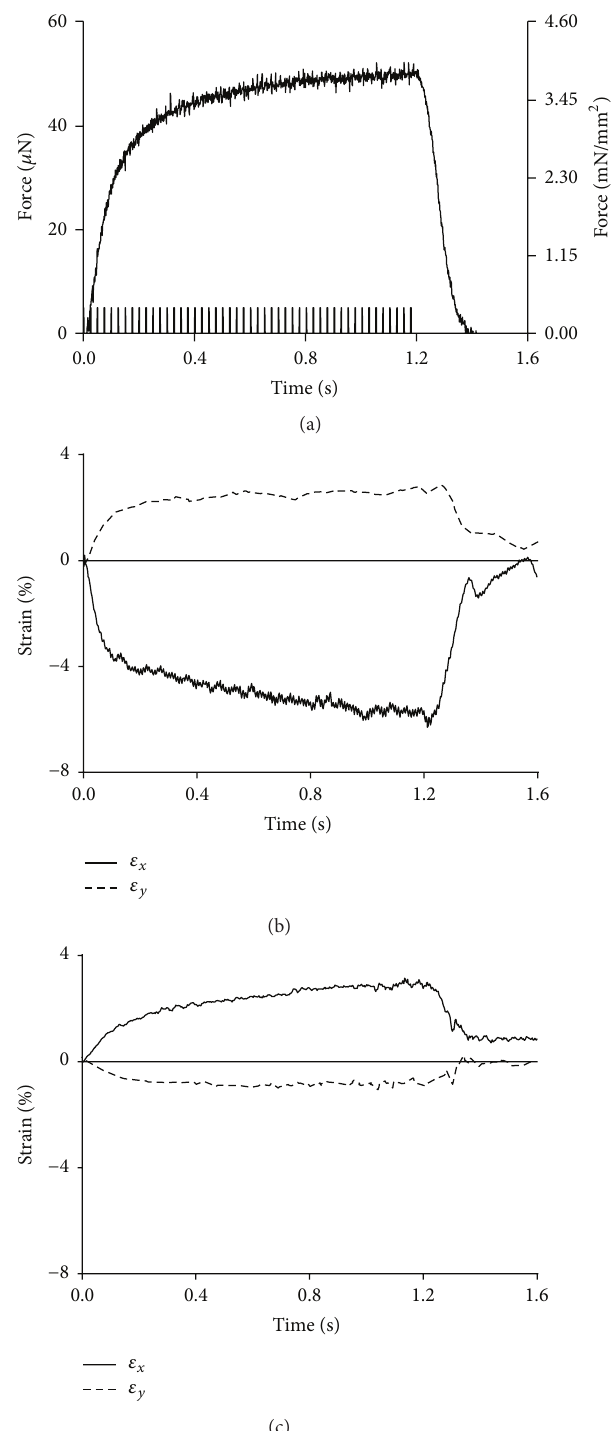
Figure 5: Electrical stimulation. Example of force (a) and strain responses obtained stimulating an X-MET at tetanic frequency and focusing once close to the fixed pin (b) and once on the center (c) of the tissue. Images are acquired at 400